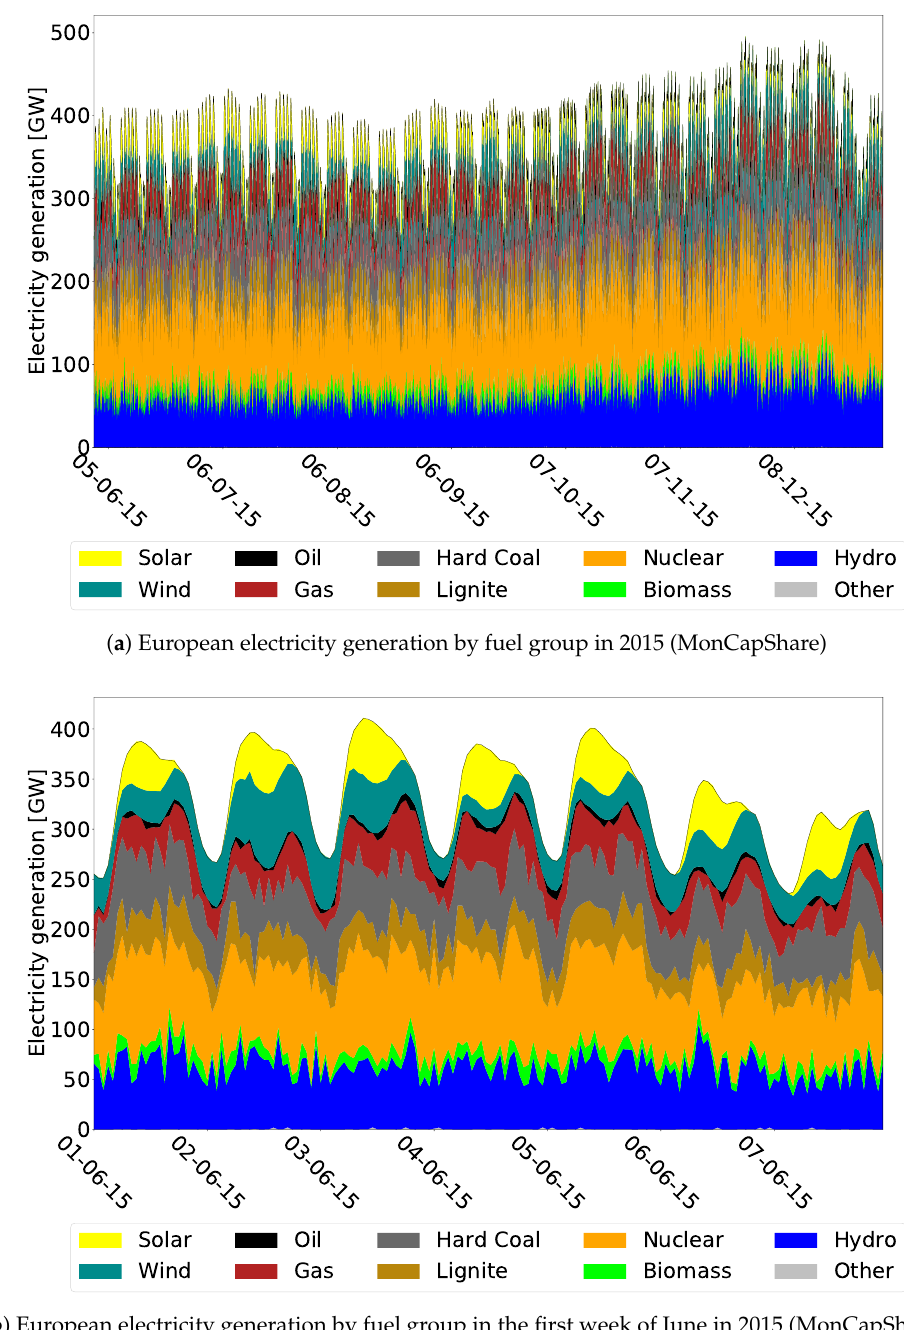
Figure 3. European electricity generation by fuel